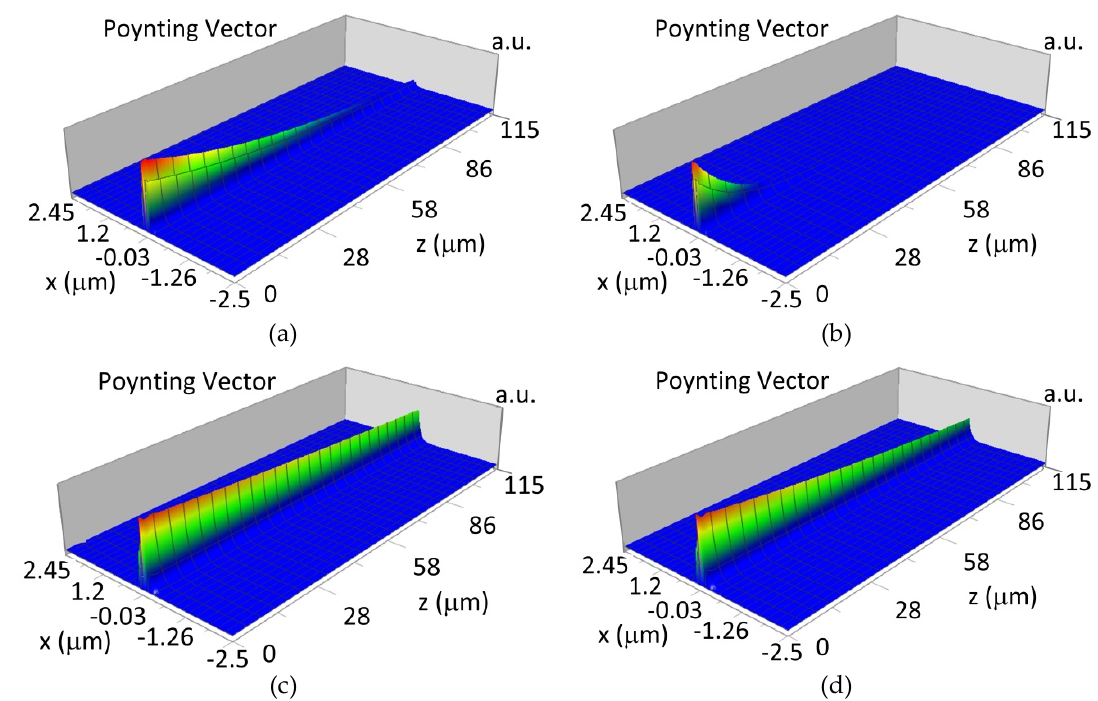
Figure 12. Propagation light in single-mode waveguide structure for TM00, d w = 85 nm (Poynting vector): ( a ) λ = 436 nm, Hb O2 , ( b ) λ = 436 nm, Hb, ( c ) λ = 560 nm, Hb O2 , ( d ) λ = 560 nm, Hb.